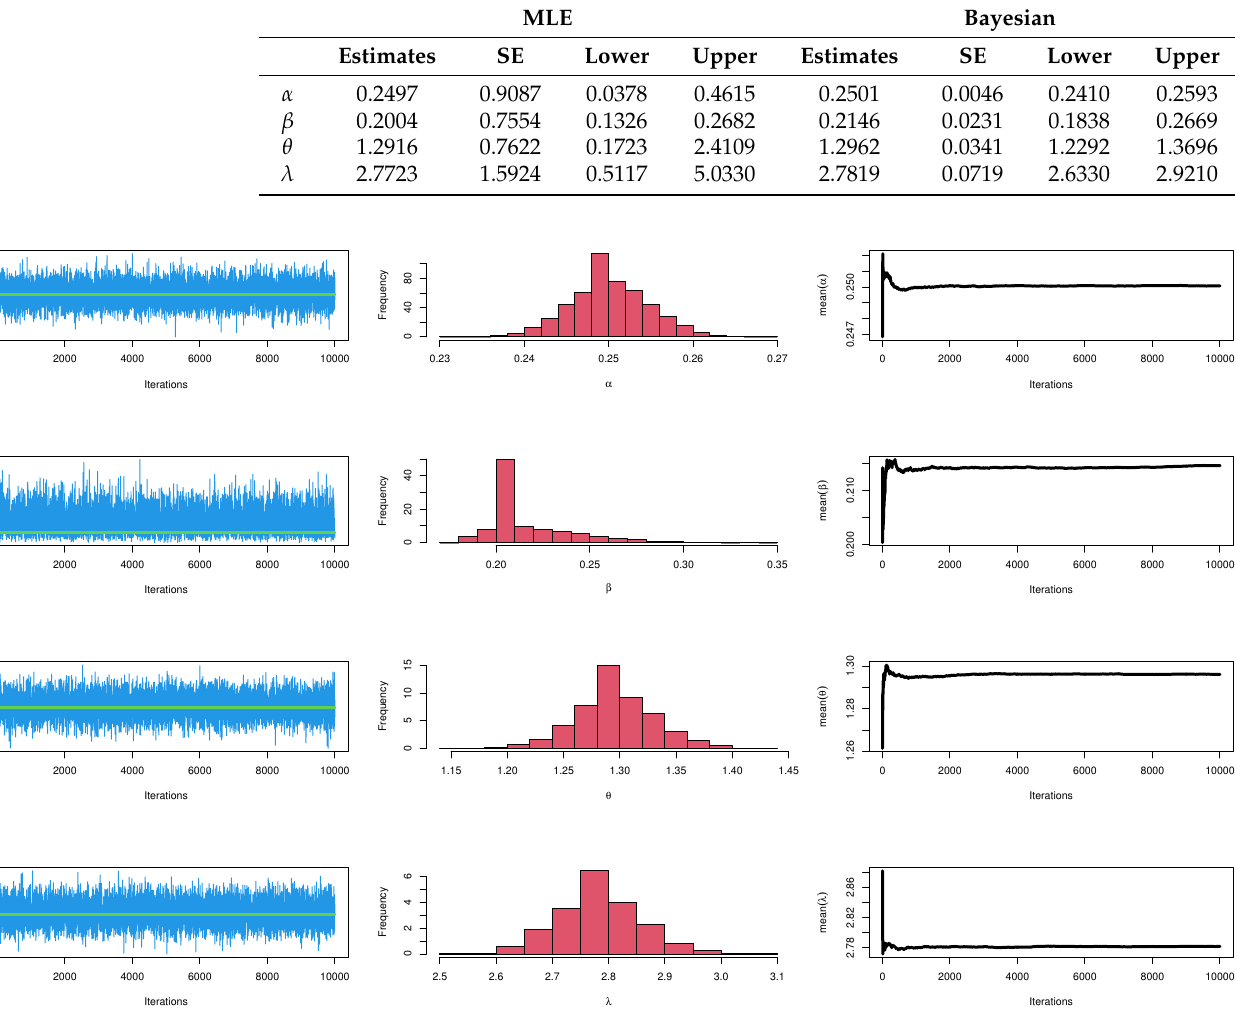
Figure 15. MCMC plots for parameters of TLMW model for Guinea Pigs data.